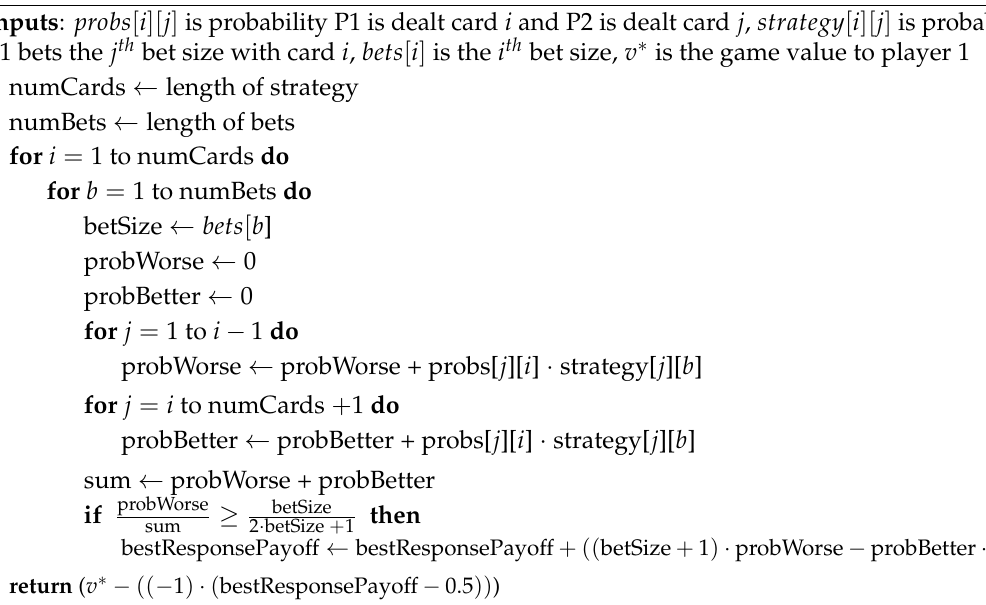
Algorithm 3 Compute